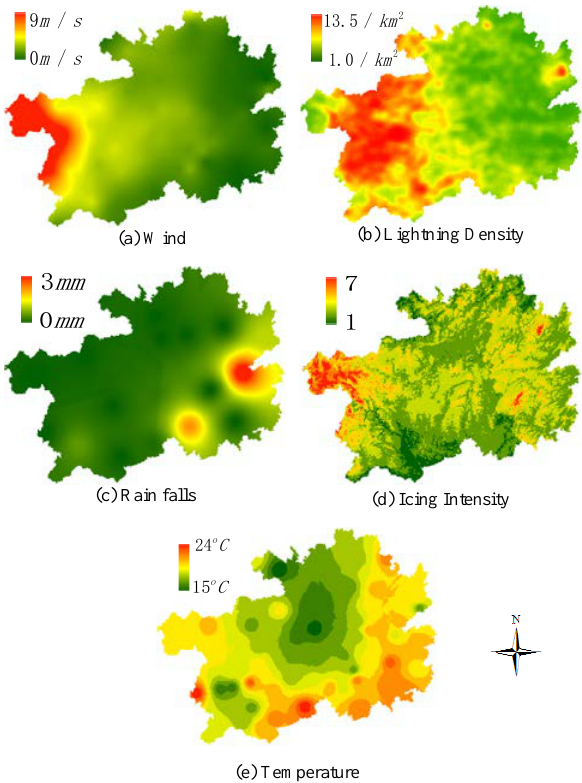
Figure 6 Interpolated meteorological raster